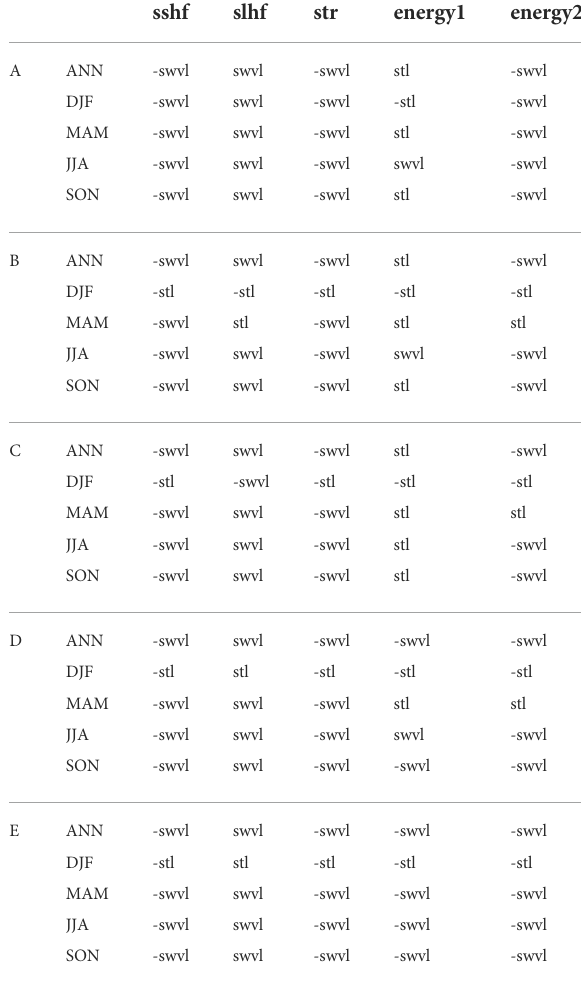
TABLE 2 Dominant ground variables of the whole year and four seasons in various regions.